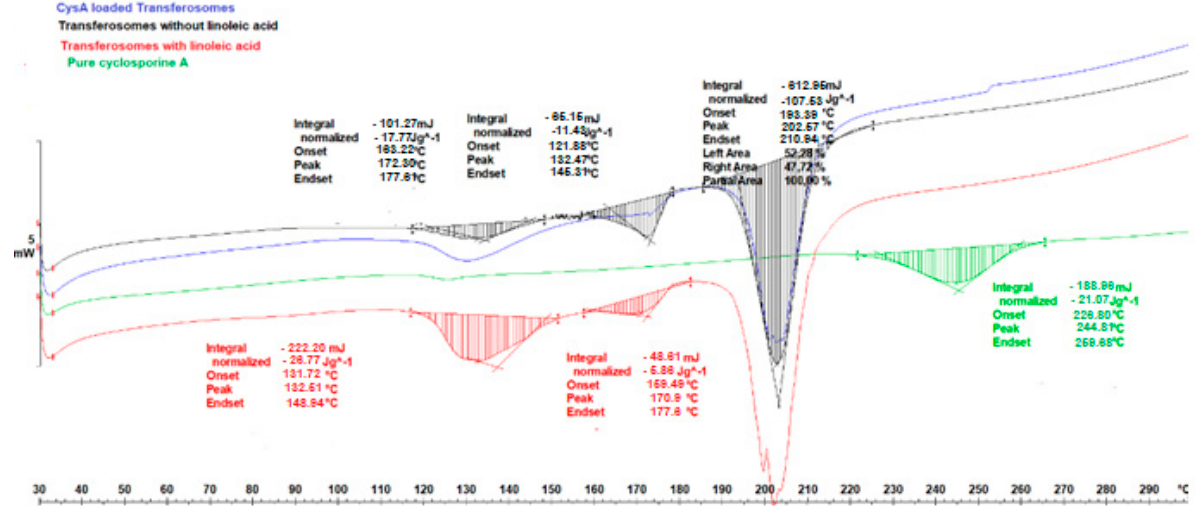
Figure 2. Differential scanning calorimetry of pure CysA, drug-free (with and without linoleic acid), and CysA-loaded transferosomes.